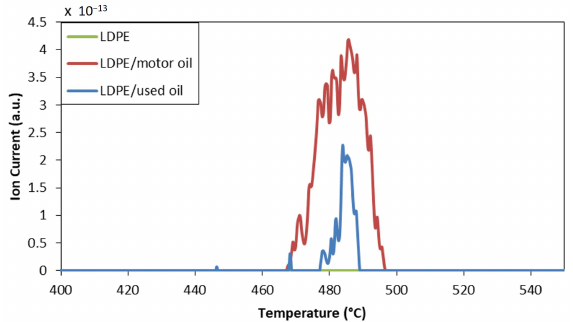
Figure 4. Evolution of m/z 84 during the decomposition of pure LDPE and LDPE-oil mixtures, as measured with